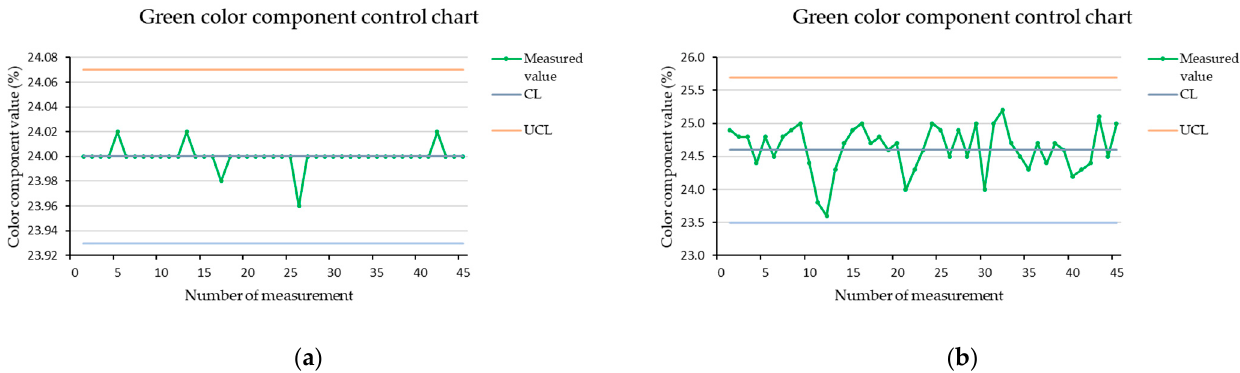
Sensors 2021 , 21 , x FOR PEER REVIEW Figure 6. Green color component control chart for a brown cube measured in the dark, at a scanning distance of 15 mm; ( a ) stopped cube; ( b ) cube in motion.